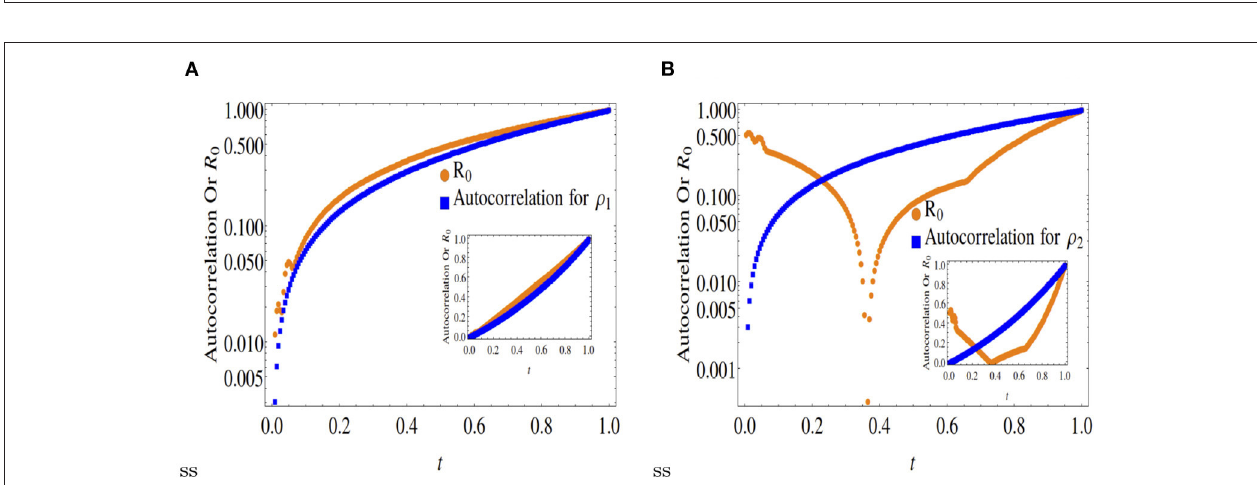
FIGURE 3 | Comparison of normalized autocorrelation and R 0 at x = 0.5. Outset is in log scale and inset is in original scale. (A) Shows similar trend for R 0 and autocorrelation as in Figure 2A , which indicates that the production of ρ 1 is boosted by the abundance of its ancestor. (B) Whereas, the production of ρ 2 occurs both by the conversion of ρ 1 for some time and due to its own population at later times.